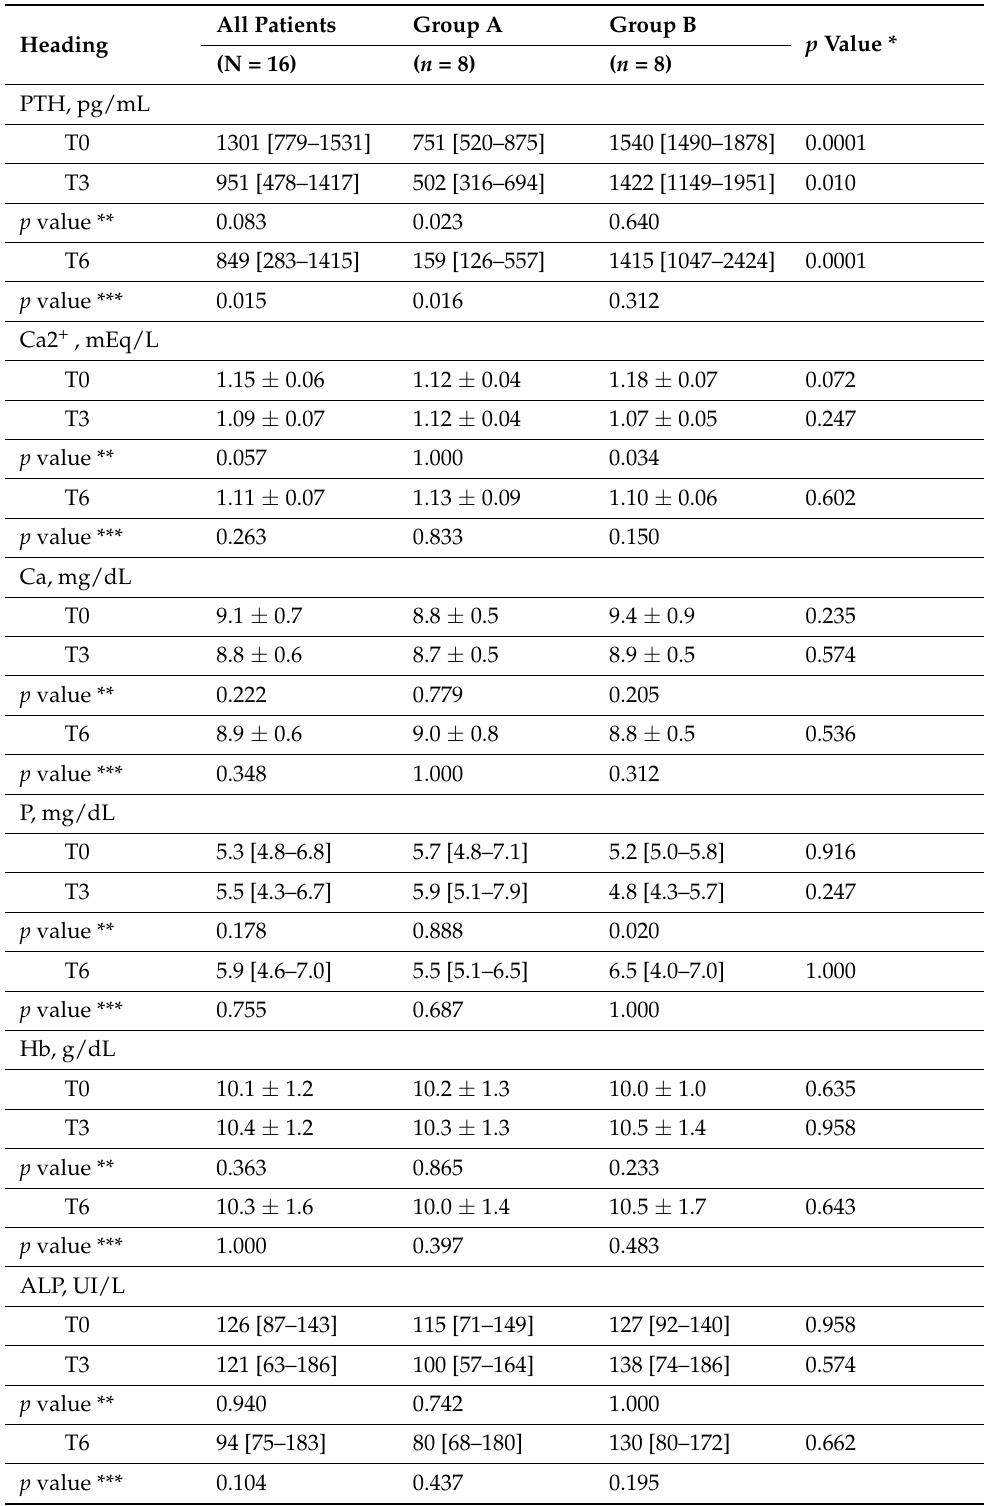
Table 3. Mean and median changes in laboratory values at T0, T3, and T6 in all patients and in subgroups A and B. Values are expressed as mean ± standard deviation or, in case of non-Gaussian distribution, as median [interquartile range]. * difference between group A and group B; ** difference in each group between T0 and T3; *** difference in each group between T0 and